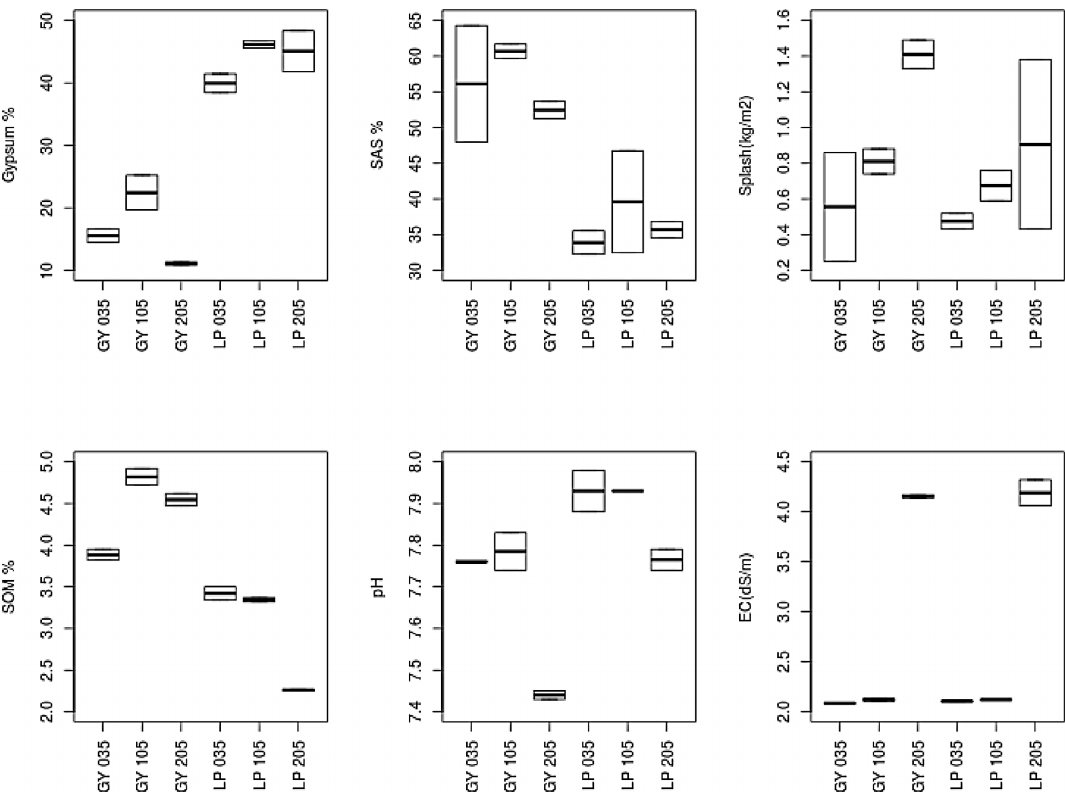
Fig. 3. Box plot of the soil